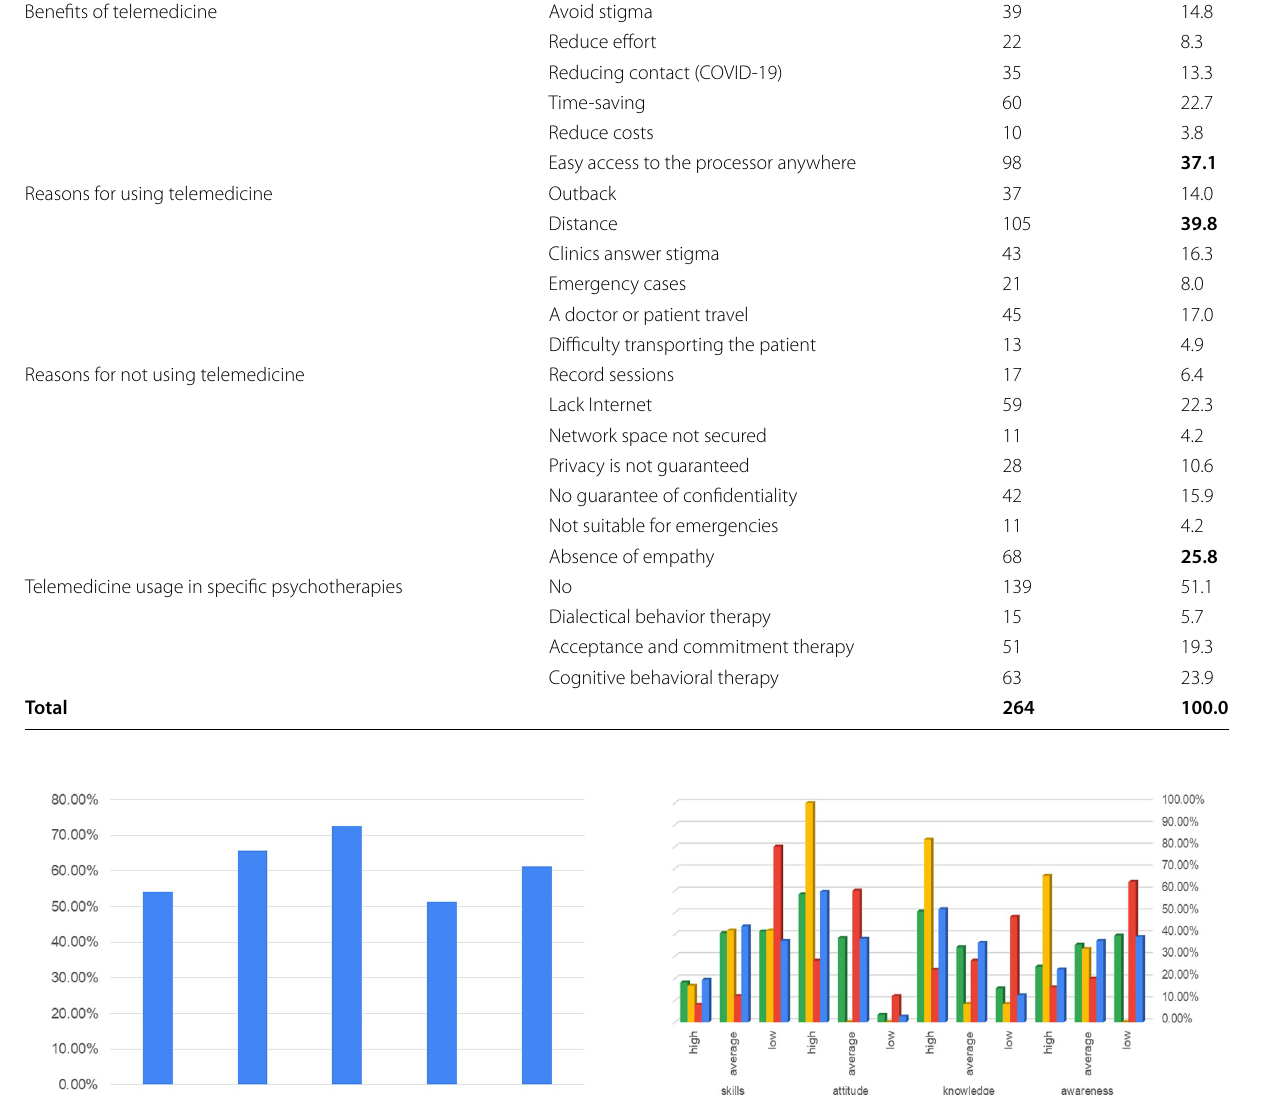
Table 3 Telemedicine usage among mental healthcare providers ( n Telemedicine usage Items